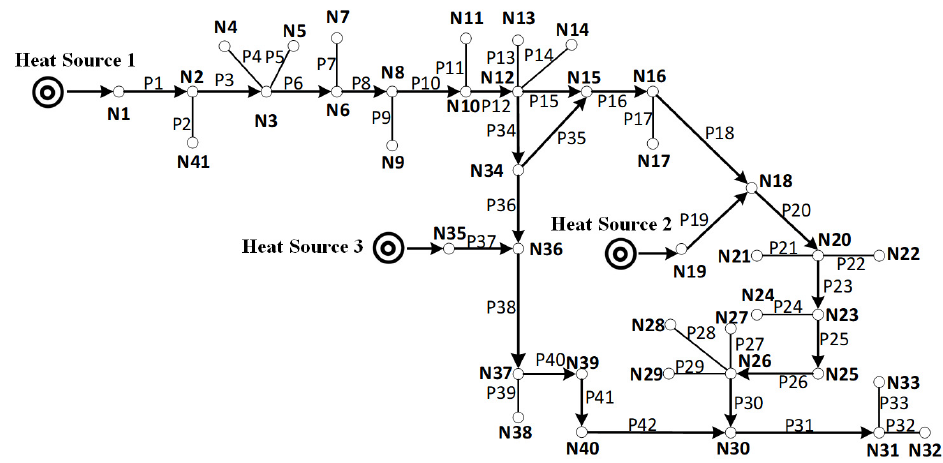
Figure 5. China 41-node heating grid model.